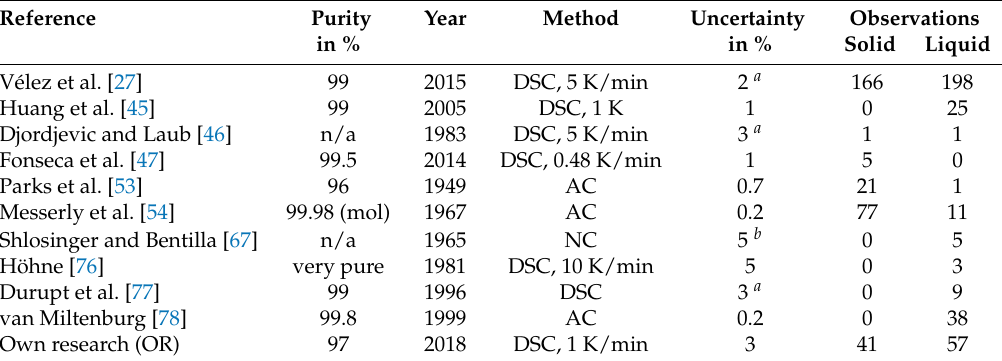
Table 3. Summary of heat capacity data from the literature. The number behind the abbreviation DSC describes either the heating rate (K/min) or the step size (K) of the applied measurement method.